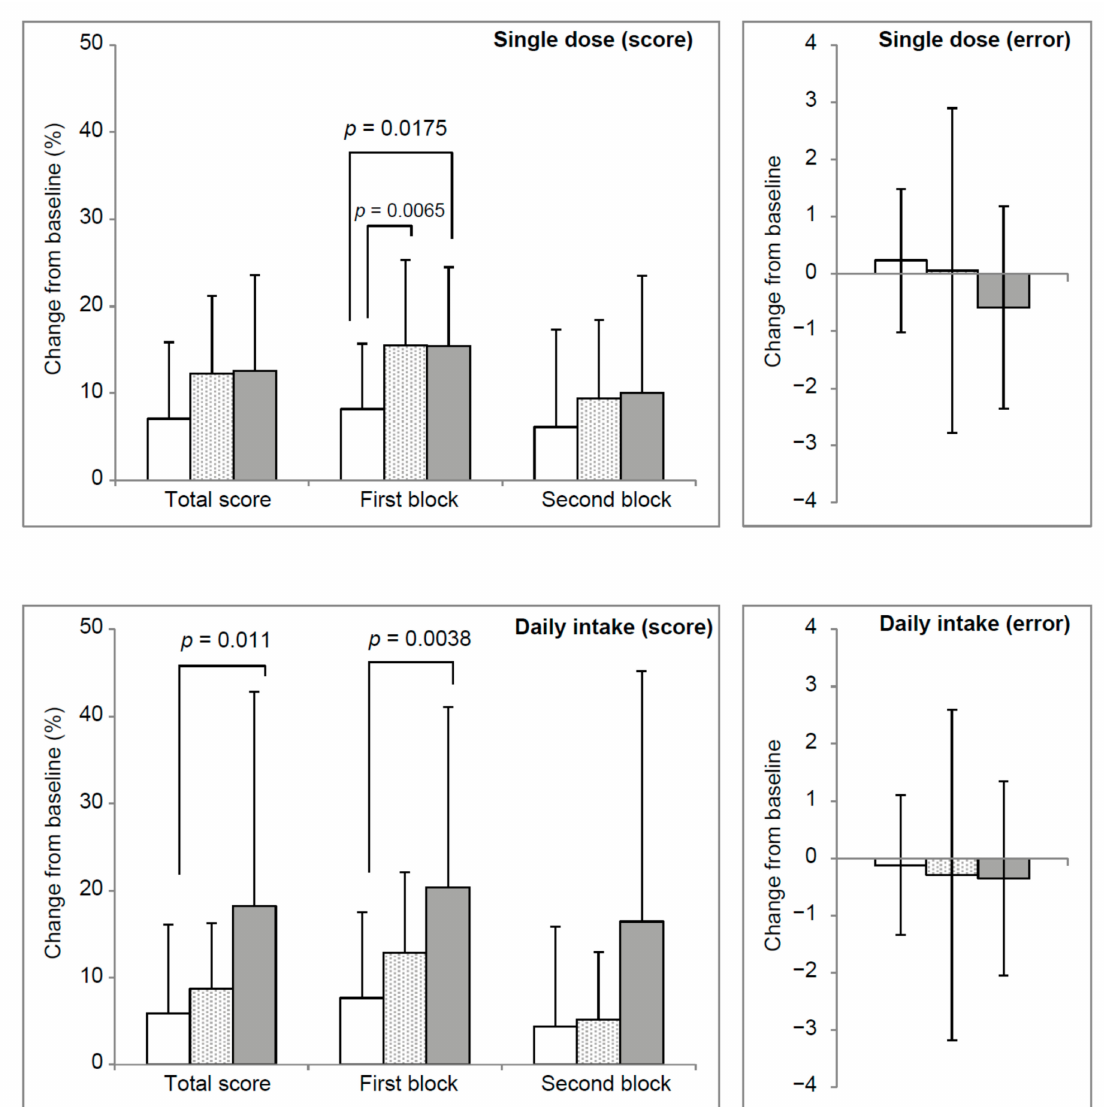
Figure 2. Number of answers and errors during a mild acute stress task and intake of matcha or caffeine. Shown are the placebo group (white bar), caffeine group (shadow bar), and matcha group (grey bar). Each bar shows the mean ± standard deviation. Group (inter) analysis was performed using the Kruskal–Wallis test (KW) followed by a post-hoc Mann–Whitney U test at each time point to test for inter-group outcomes (control vs. caffeine, control vs. matcha, and caffeine vs. matcha). The p -value was determined using a Bonferroni correction of p < 0.05/3 = 0.017; p < 0.01/3 = 0.0033 vs. placebo